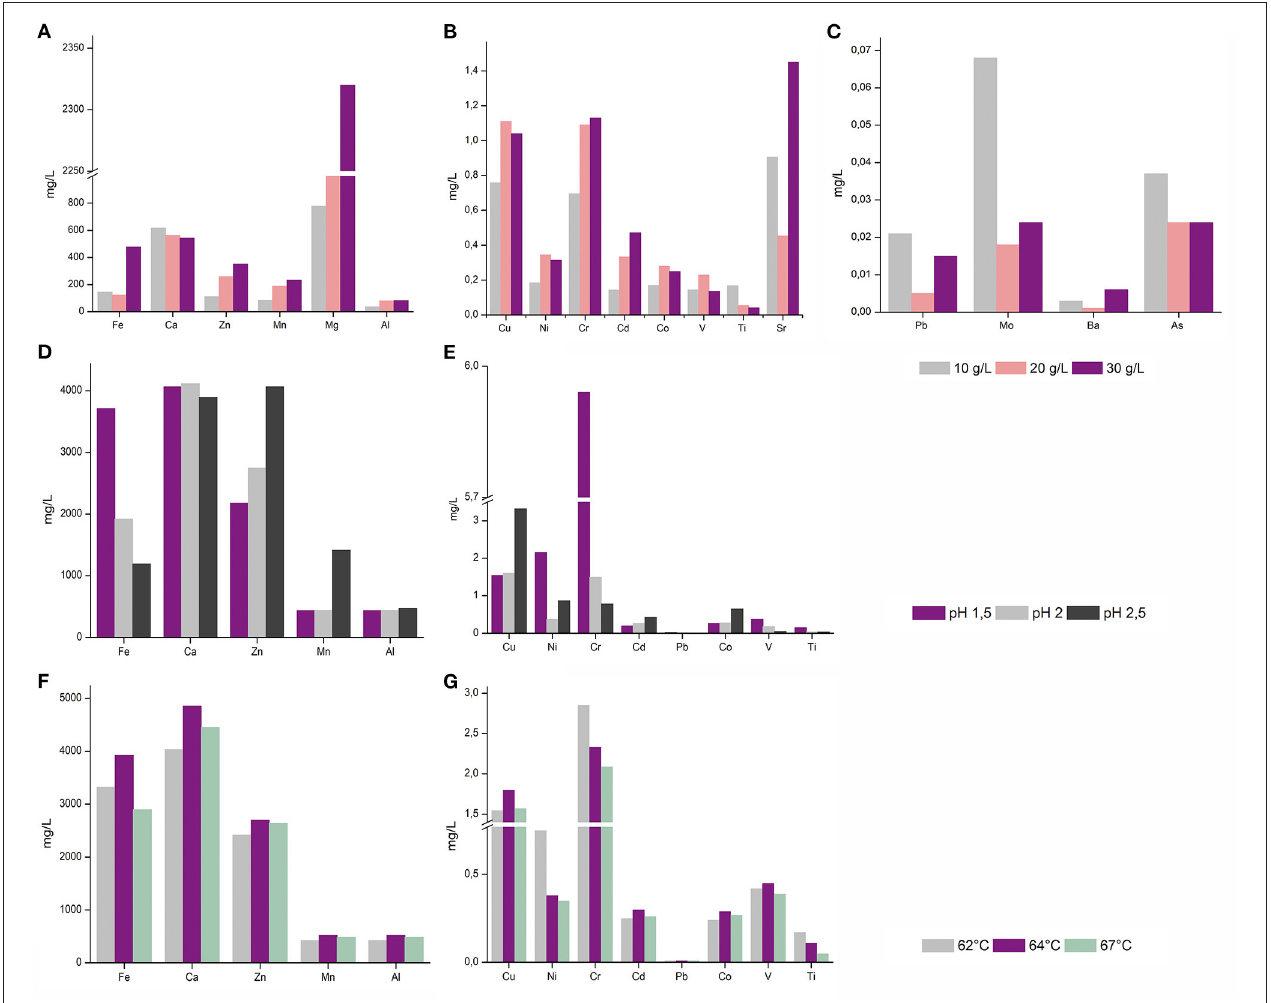
FIGURE 3 | ICP-MS analysis of released metal ions in leachate solution of A. manzaensis grown on BOF-dust at different parameters. (A–C) A. manzaensis grown on increasing amounts of dust (10/20/30 g/L); (D,E) A. manzaensis grown at different pH values (1.5/2.0/2.5); (F,G) A. manzaensis grown at different temperatures (62 ◦ C/64 ◦ C/67 ◦